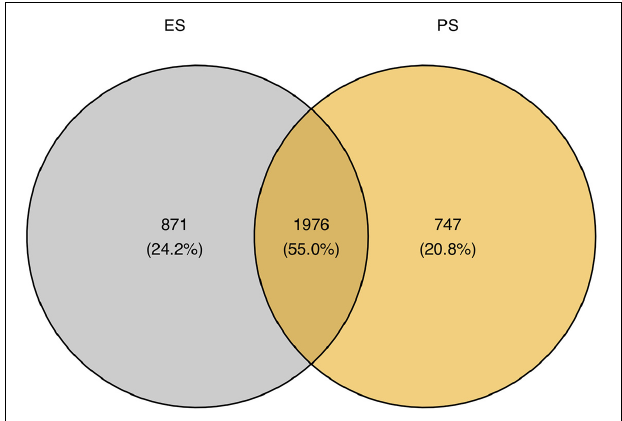
FIGURE 6 | Comparison of genomic locations of G-to-A RNA editing events between ES and